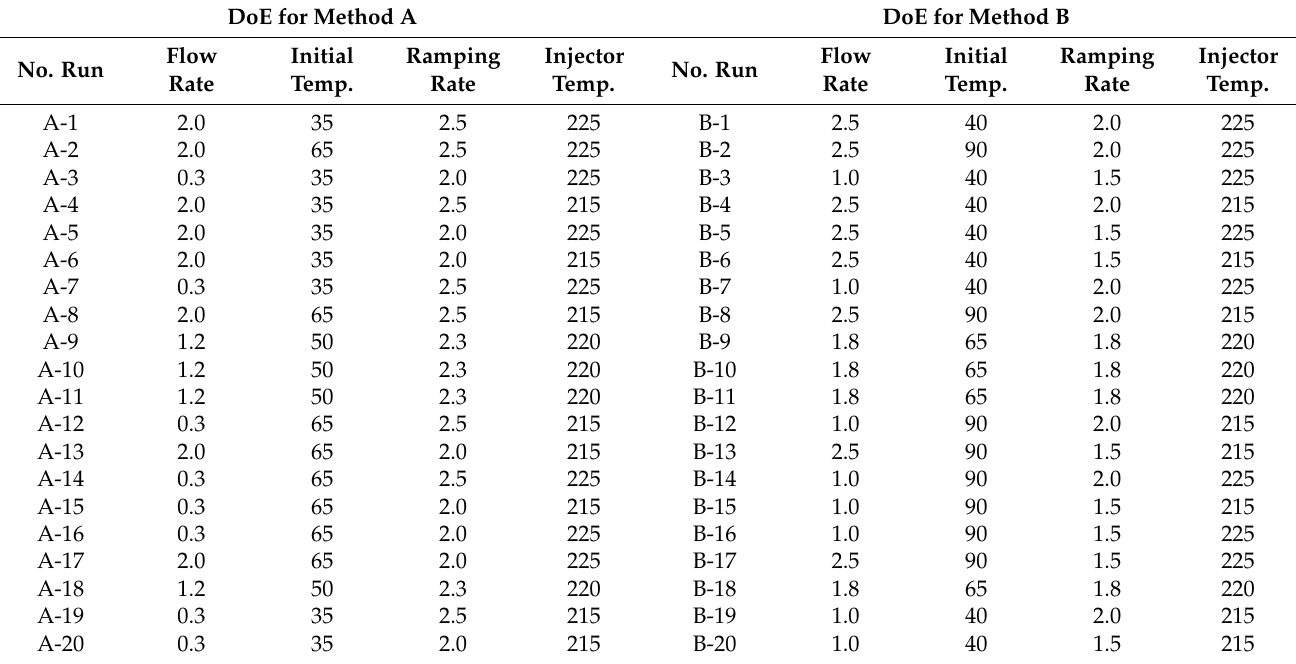
Table 2. Design of experiment (DoE) for screening.